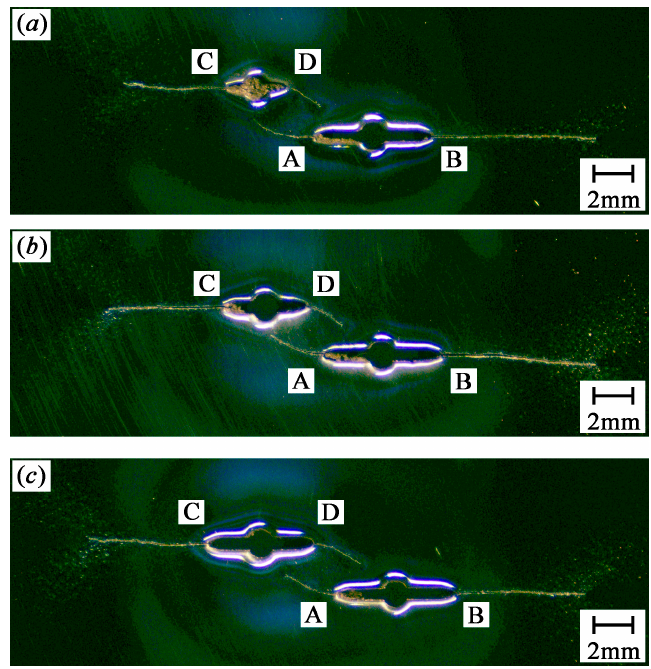
Figure 3. Crack growth paths for different specimens: ( a ) PC0.5s6, ( b ) PC0.7s6, and ( c ) PC0.9s7.